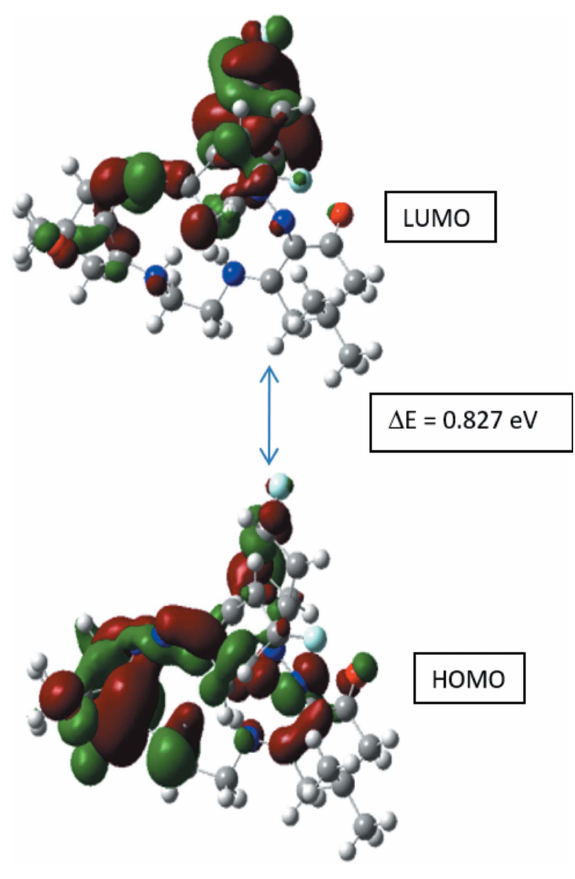
Figure 5 The frontier molecular orbitals of